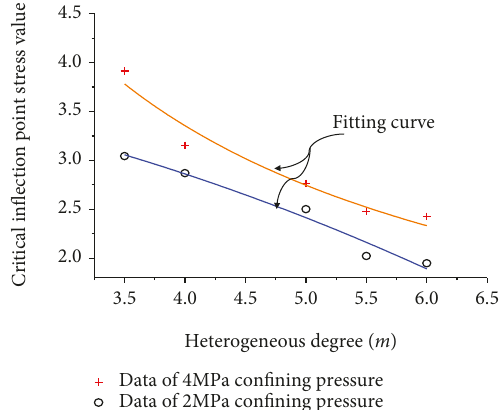
Figure 6: Determination of the critical phase and critical in fl ection point.